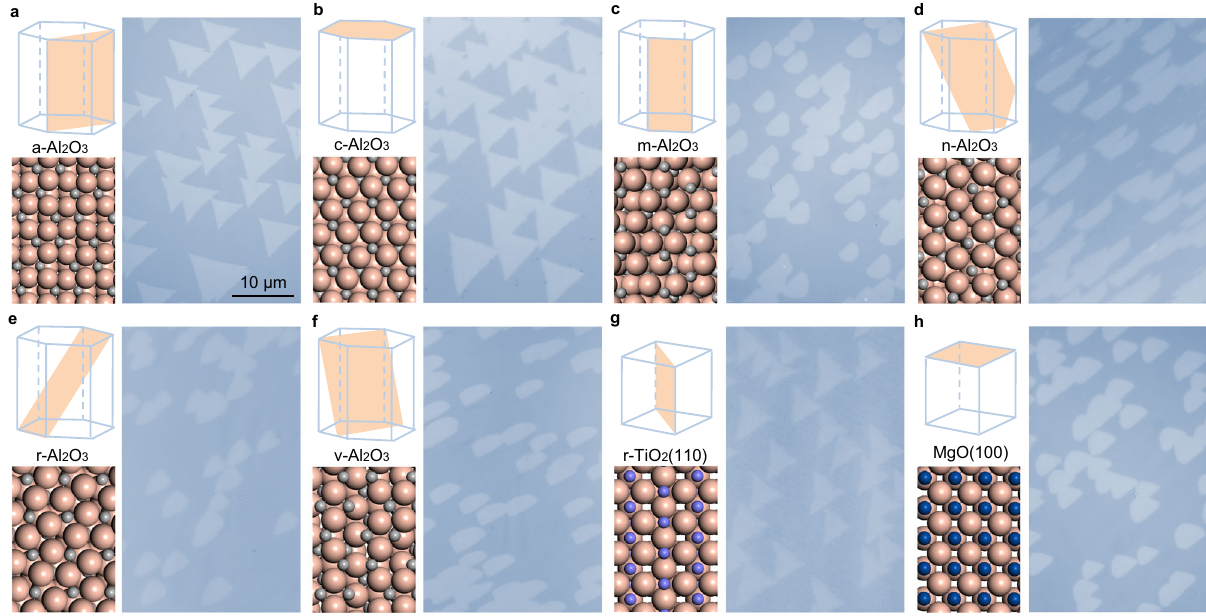
Fig. 3 | Universal growth of unidirectionally aligned MoS 2 grains on various substrates. Schematic diagrams of lattice structures of the substrates and optical imagesofMoS 2 grainsgrownonthem.UnidirectionallyalignedMoS 2 grainscanbe produced on a- ( a ), c- ( b ), m- ( c ), n- ( d ), r- ( e ), v-Al 2 O 3 ( f ), r-TiO 2 (110) ( g ), and